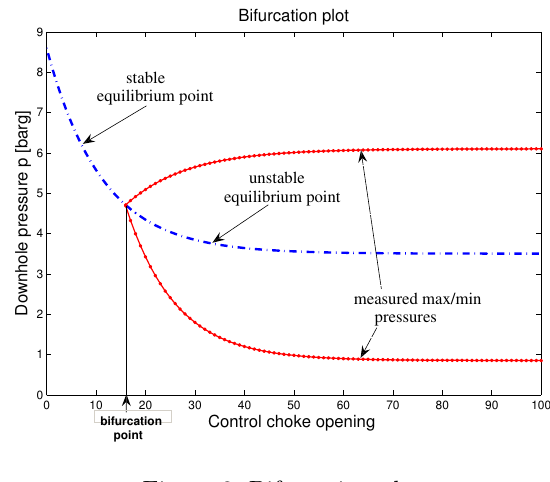
Figure 2: Bifurcation